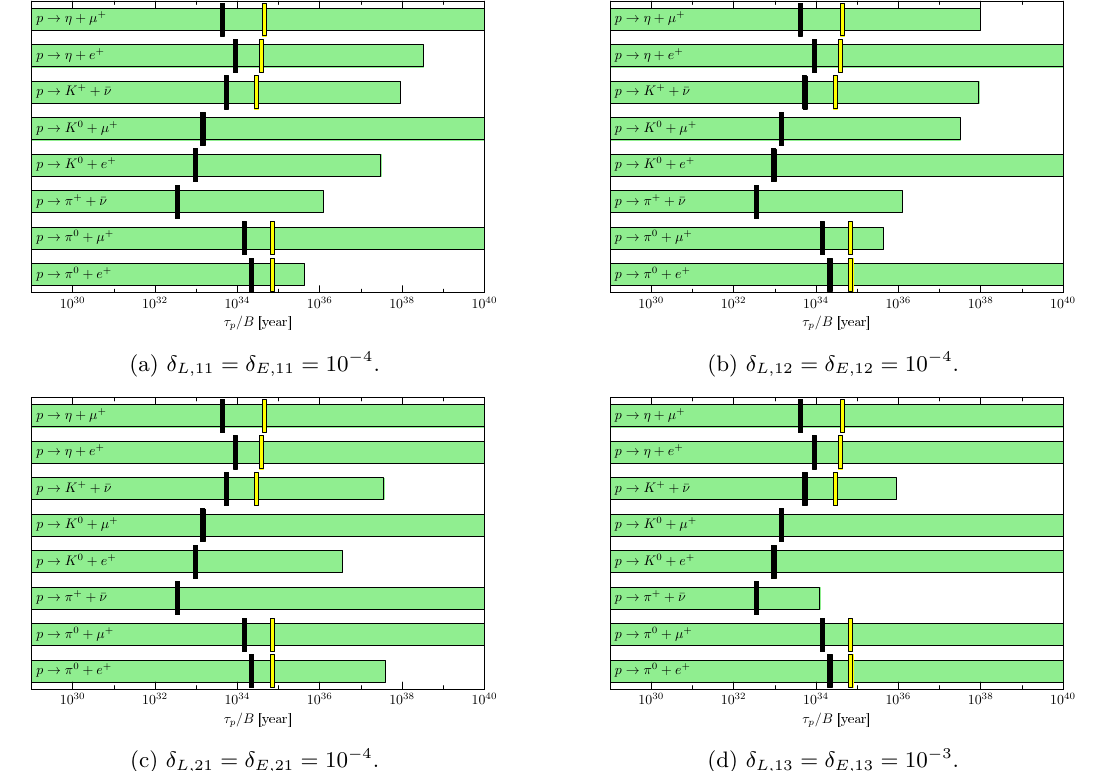
Figure 2. The proton lifetime of each decay mode. Here, we switch on the mixing parameters in eq. (3.22) as indicated by the subcaptions. We take M X = 10 14